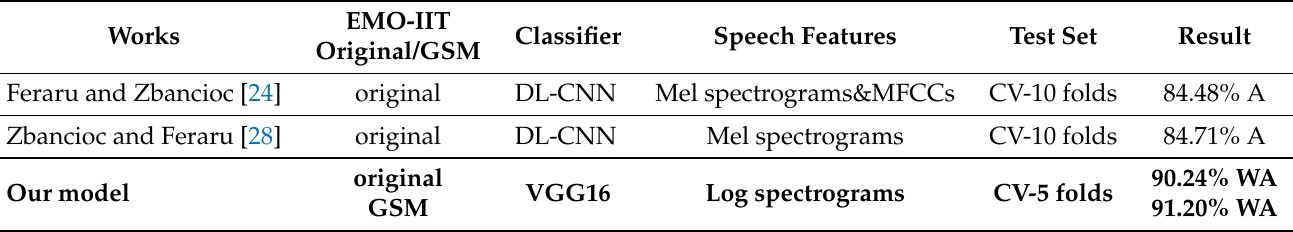
Table 9. Comparison of EMO-IIT results (bold marks the best model).